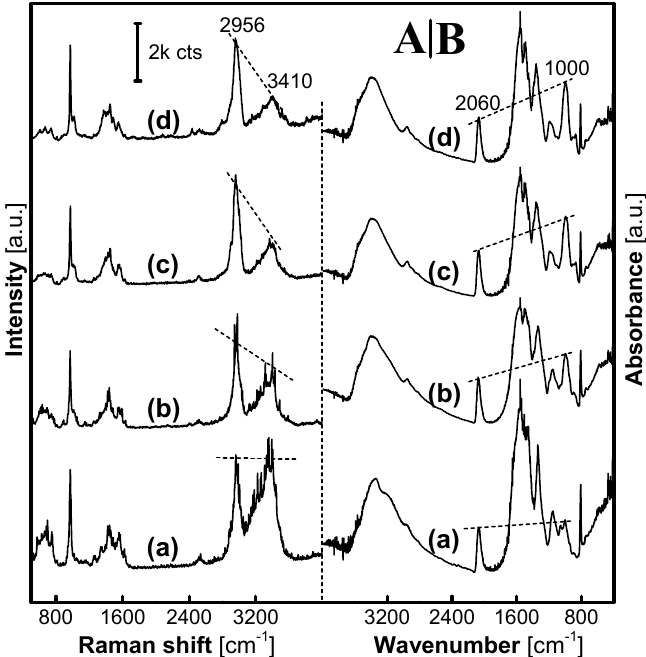
Figure 2. Raman and IR spectra of a set of MFMSs synthesized in 3 h. ( A ) Raman spectra of MF 1 ( a ), MF 3 ( b ), MF 7 ( c ) and MF 9 ( d ); ( B ) IR spectra of MF 1 ( a ), MF 3 ( b ), MF 7 ( c ), and MF 9 ( d ). A laser power of 20 mW was chosen in the collection of Raman spectra of MFMSs.